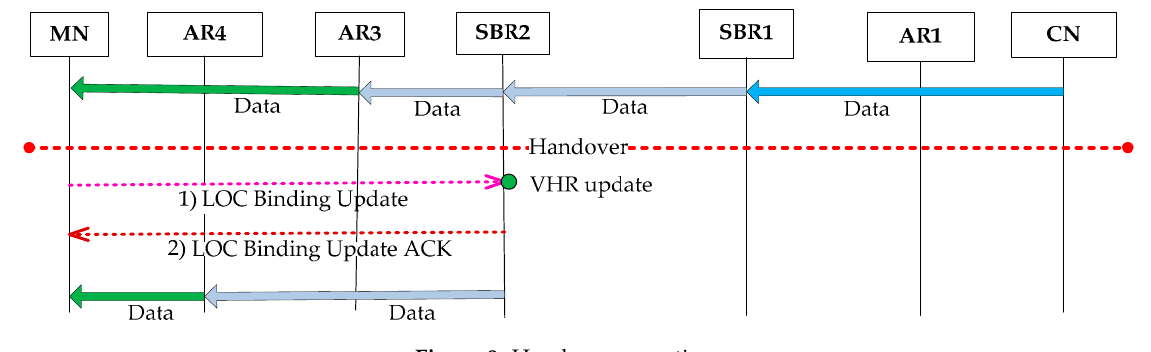
Figure 8. Handover operations.